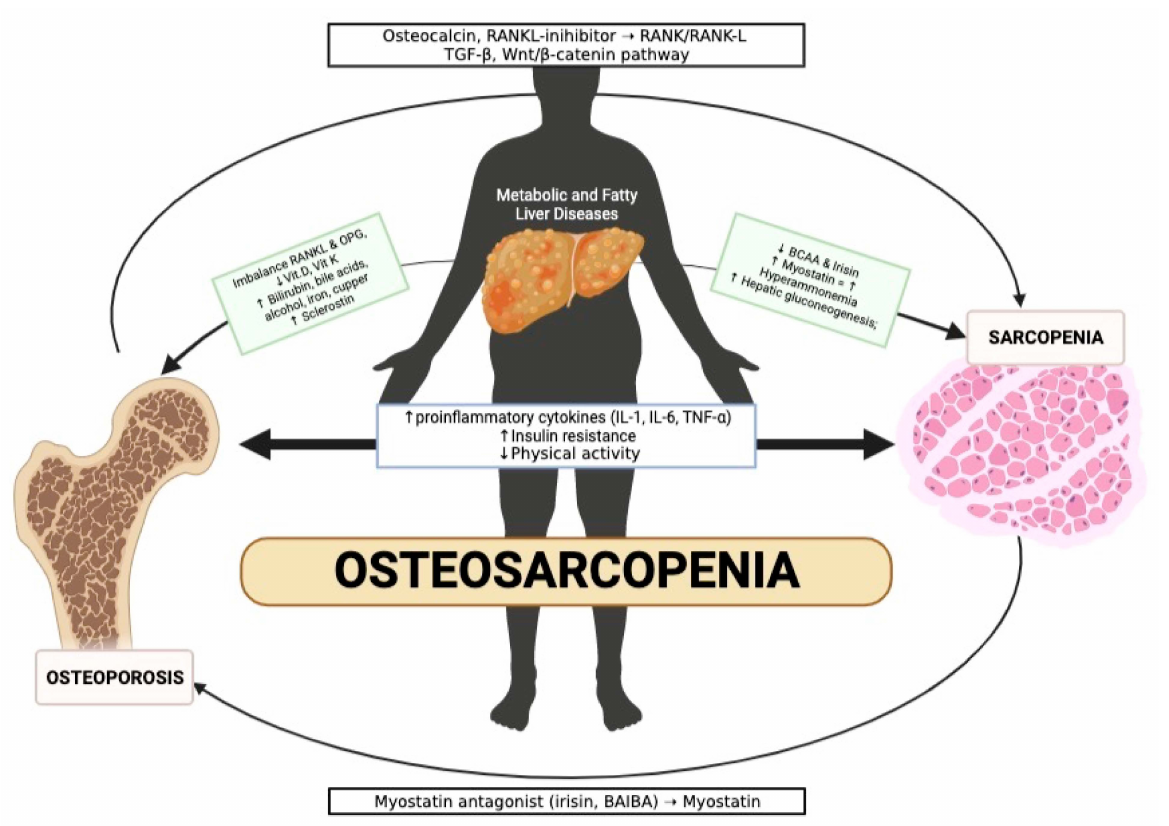
Figure 1. Pathophysiological mechanism and the association between osteoporosis and sarcopenia in non-alcoholic fatty liver